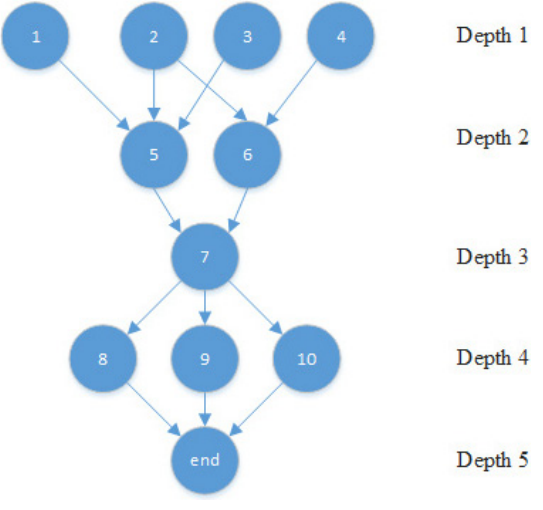
Fig. 2. Work°ow in DAG